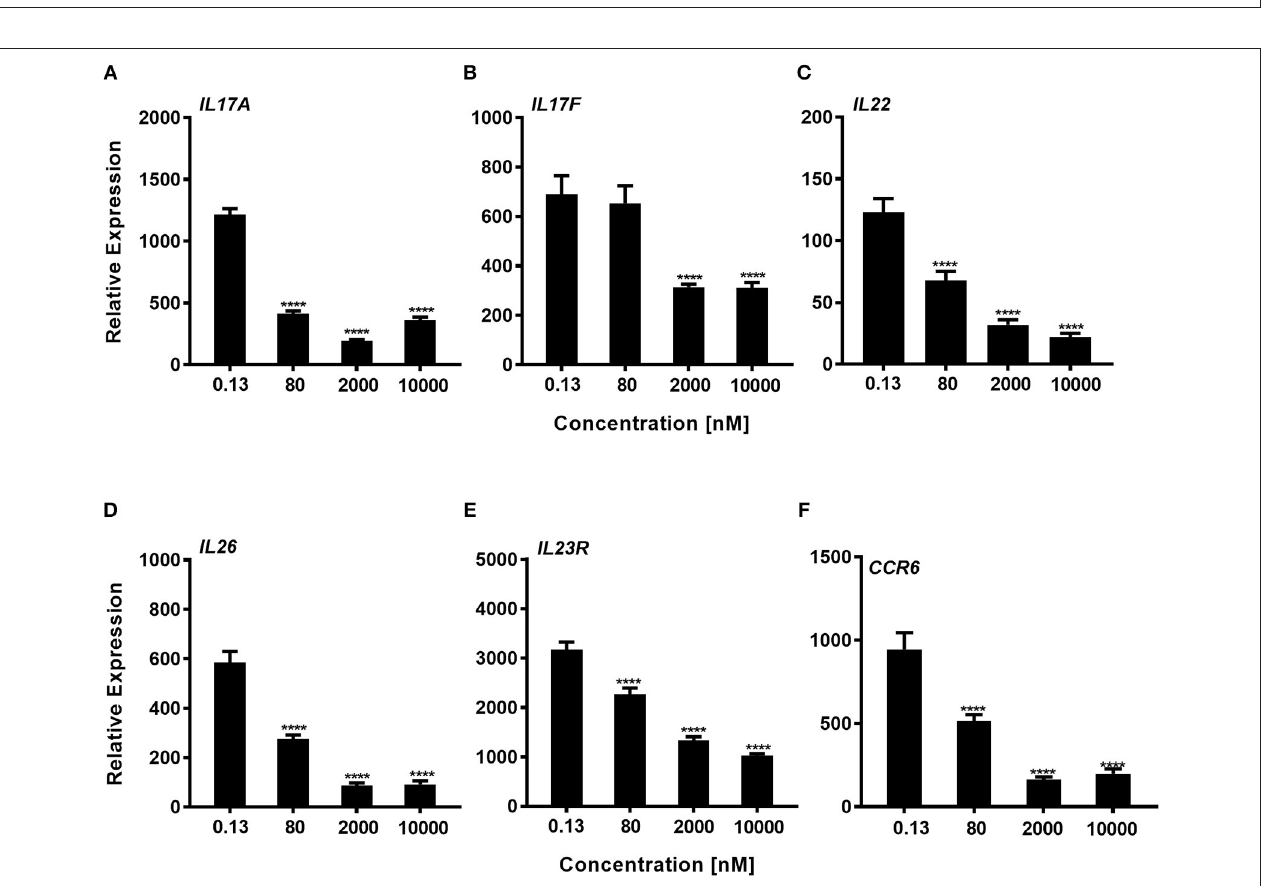
FIGURE 4 | Impaired expression of ROR γ t-regulated genes in Th17 cells after Cpd A treatment. (A–F) Various Cpd A concentrations were added at the beginning of the Th17 cell polarizations and after 72h, ROR γ t target gene expression was quantified by qRT-PCR. Gene expression was normalized to β -glucoronidase levels and expressed as arbitrary units. All graphs are representative from two experiments containing three technical replicates each. Error bars represent the SD. Significant inhibition was determined by one way ANOVA Dunnett’s test, **** p < 0.0001.